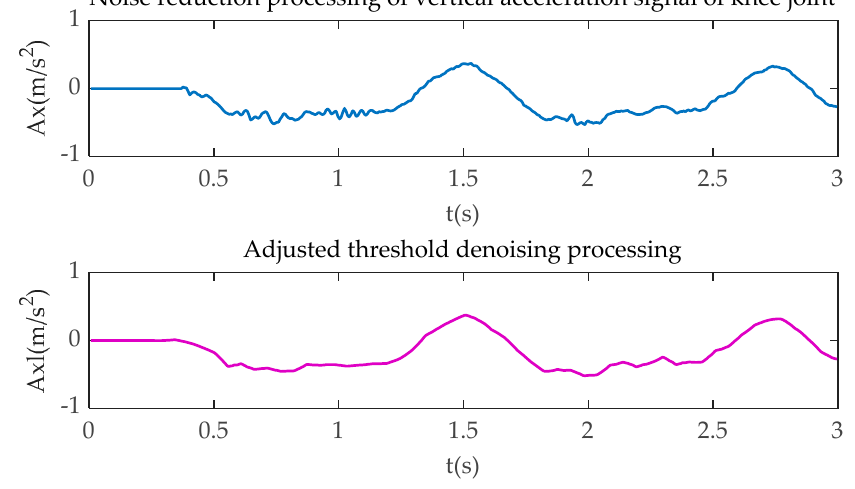
Figure 5. Knee joint vertical acceleration processing.